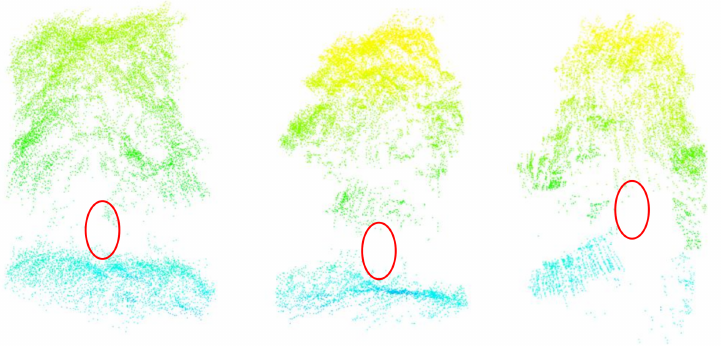
Figure 13. The red circle shows the trunk part of the three sample trees point clouds which is not clearly